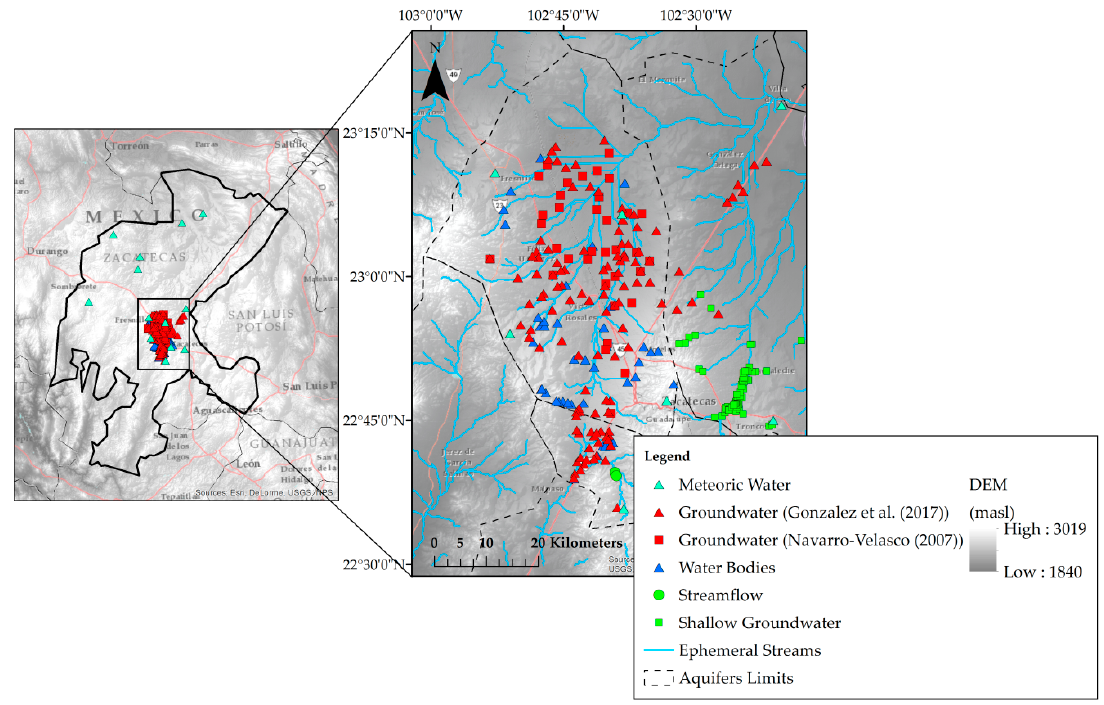
Figure 3. Sampling locations of groundwater, rainfall, streamflow water, and shallow groundwater in the study